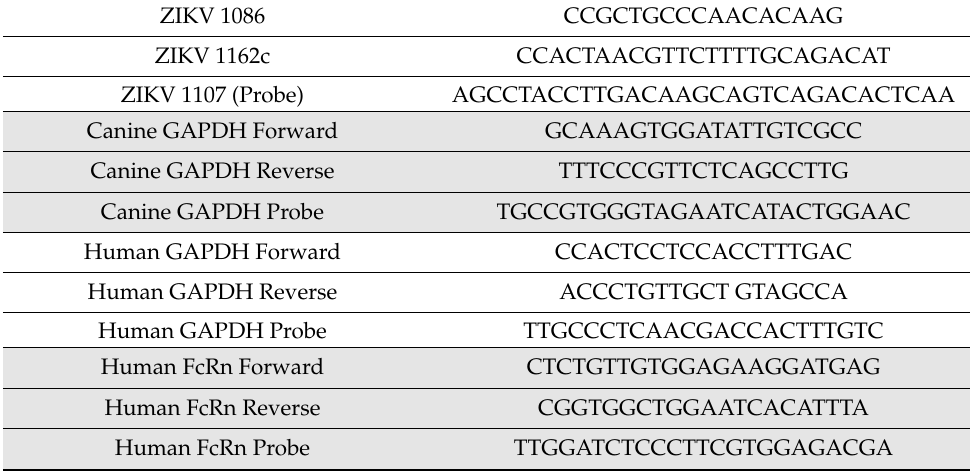
Table 1. Primers for qRT